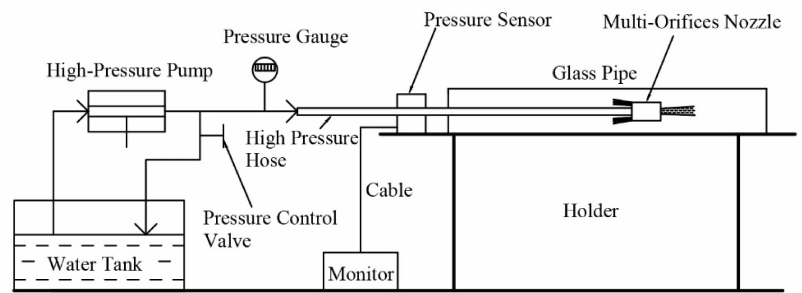
Figure 11. Device connection schematic for a self-propelling force measurement system.